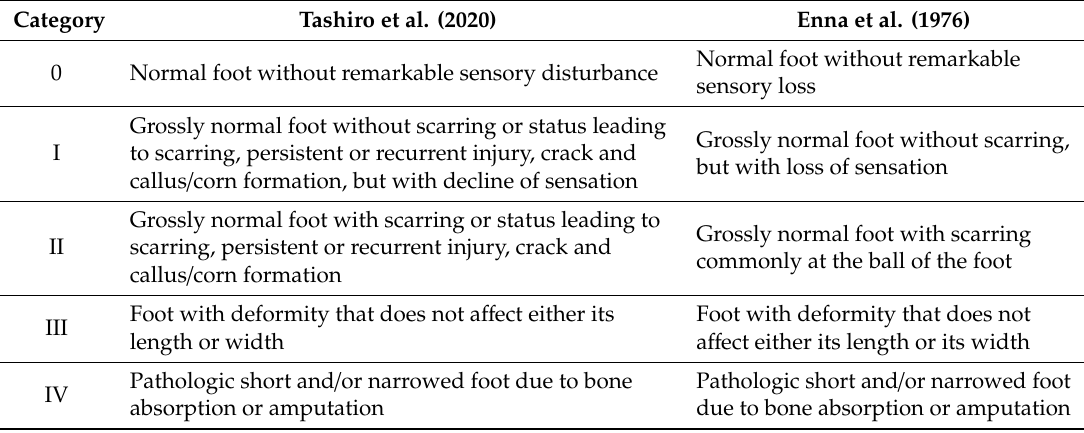
Table 1. Clinical categories of neuropathic foot in Hansen’s